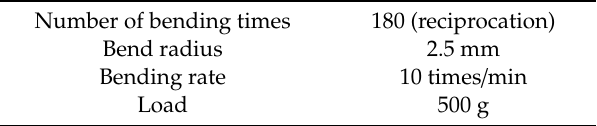
Table 2. Bending test